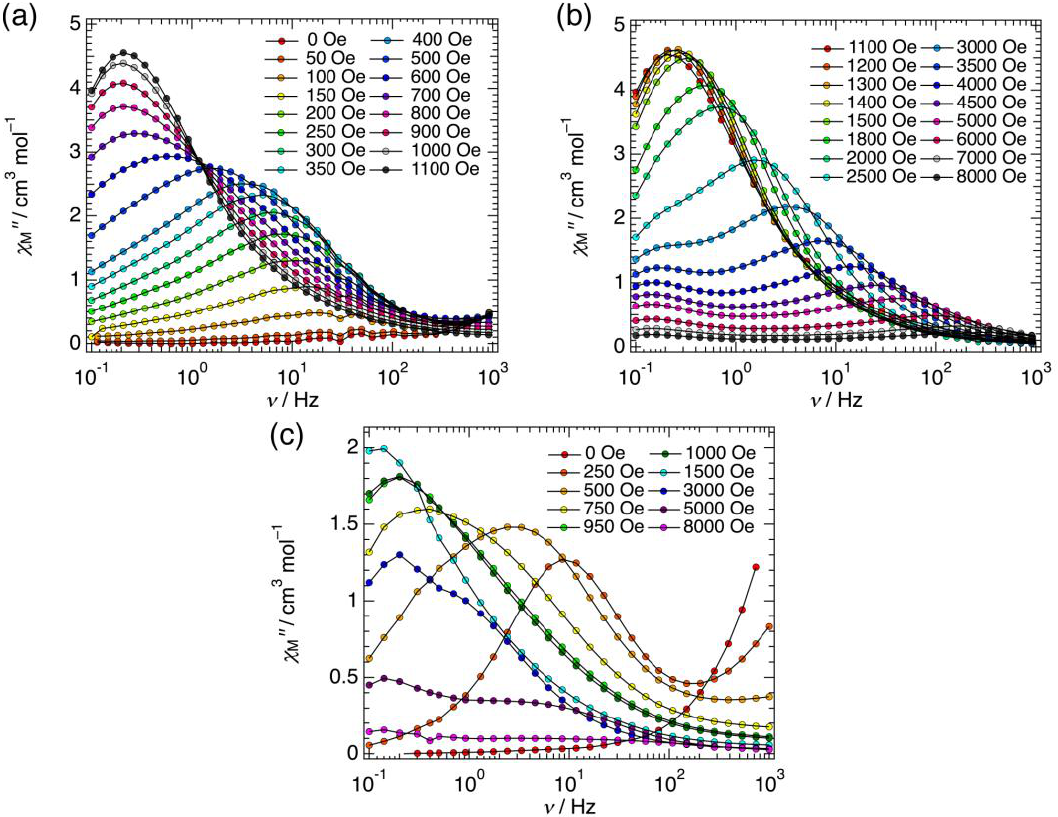
Figure 5. Variable-field χ M for 1 ( a and b ) and 3 ( c ) at 1.8 K for direct-current (DC) fields of 0–8000 Oe, over the frequency range of 0.1–1000 Hz. Solid black lines serve as guides. In addition, the other striking feature for both 1 and 3 is the clear presence of two distinct relaxation processes at higher H DC fields: the H DC -dependent component and the H DC -independent component, which are thermal and QTM relaxation modes, respectively (Figure 6).